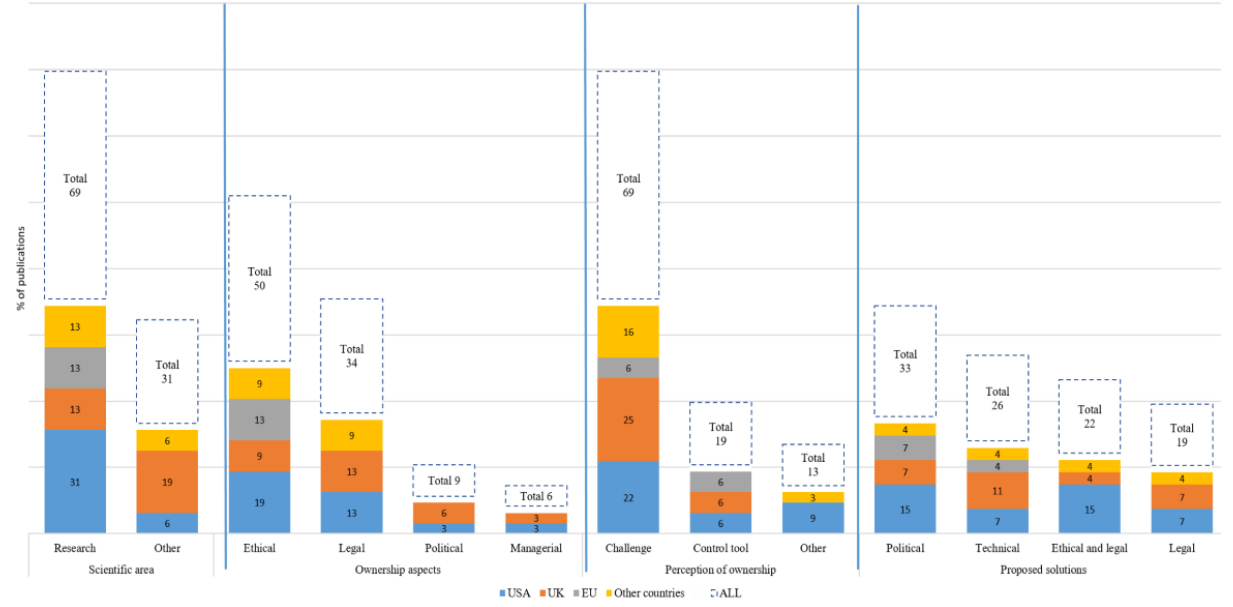
Figure 2. Distribution of the publications by countries and categories, outlining the scope of available scientific literatute on the patient information ownership in the context of big